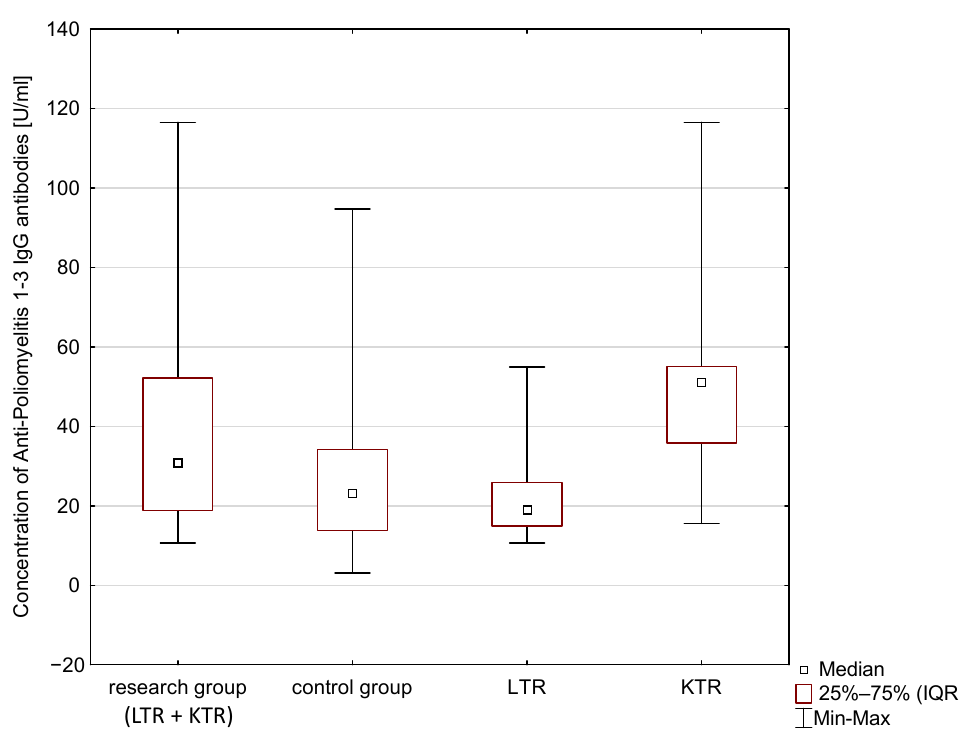
Figure 3. Concentration of Anti-Poliomyelitis Virus 1-3 IgG antibodies in blood serum. As presented in Table 5, all children obtained protective levels of post-vaccination antibodies against HBV and measles. The exception is the Anti-Poliomyelitis virus 1–3 IgG antibodies, in the case of which nearly 10% of the cases from the general paediatric